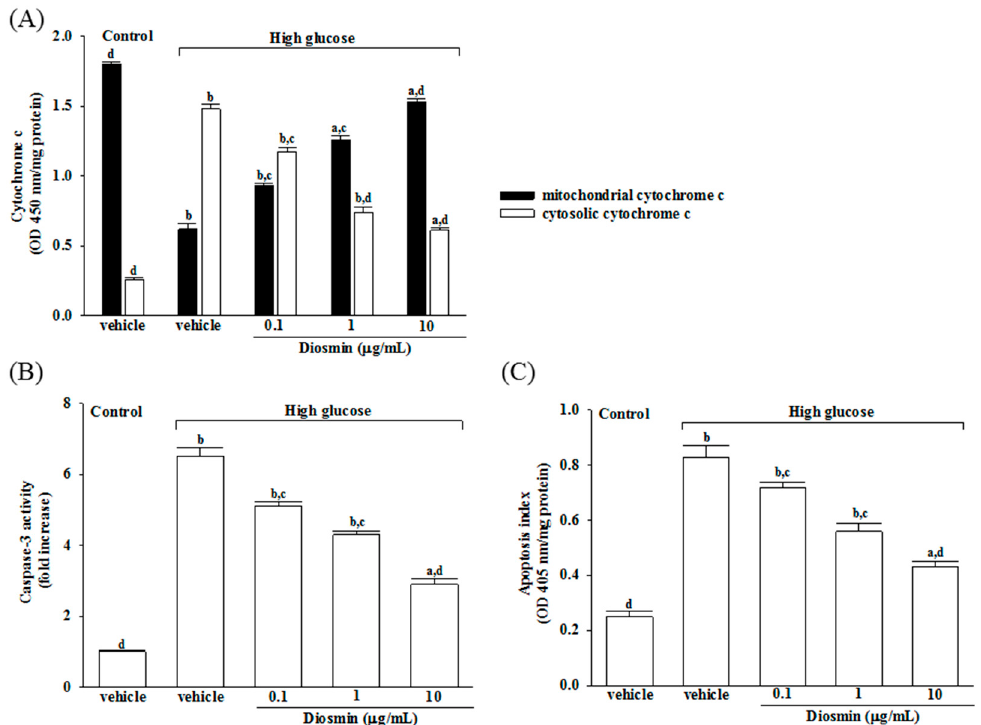
Figure 3. Effects of diosmin on high glucose-induced mitochondrial dysfunction in ARPE-19 cells. ( A ) Levels of cytochrome c in the cytosolic fraction or mitochondrial fractions were determined by ELISA kit; ( B ) The activity of caspase-3 in the cell lysate was measured using a colorimetric caspase-3 assay kit; ( C ) Apoptosis index was measured by detection of DNA fragmentation with the Cell death detection ELISA kit. Each column represents means ± SD ( n = 5 per group). a p < 0.05 and b p < 0.01 compared with normal-glucose vehicle-treated group (control), respectively. c p < 0.05 and d p < 0.01 compared with high-glucose vehicle-treated group, respectively.